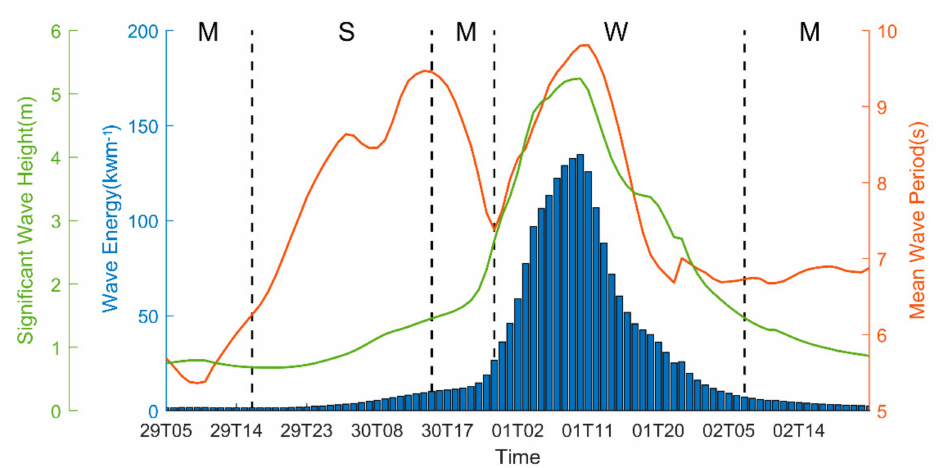
Figure 5. The wave energy (WE), mean wave period (MWP) and significant wave height (SWH). (M means mix wave, the S means swell, and the W means wind